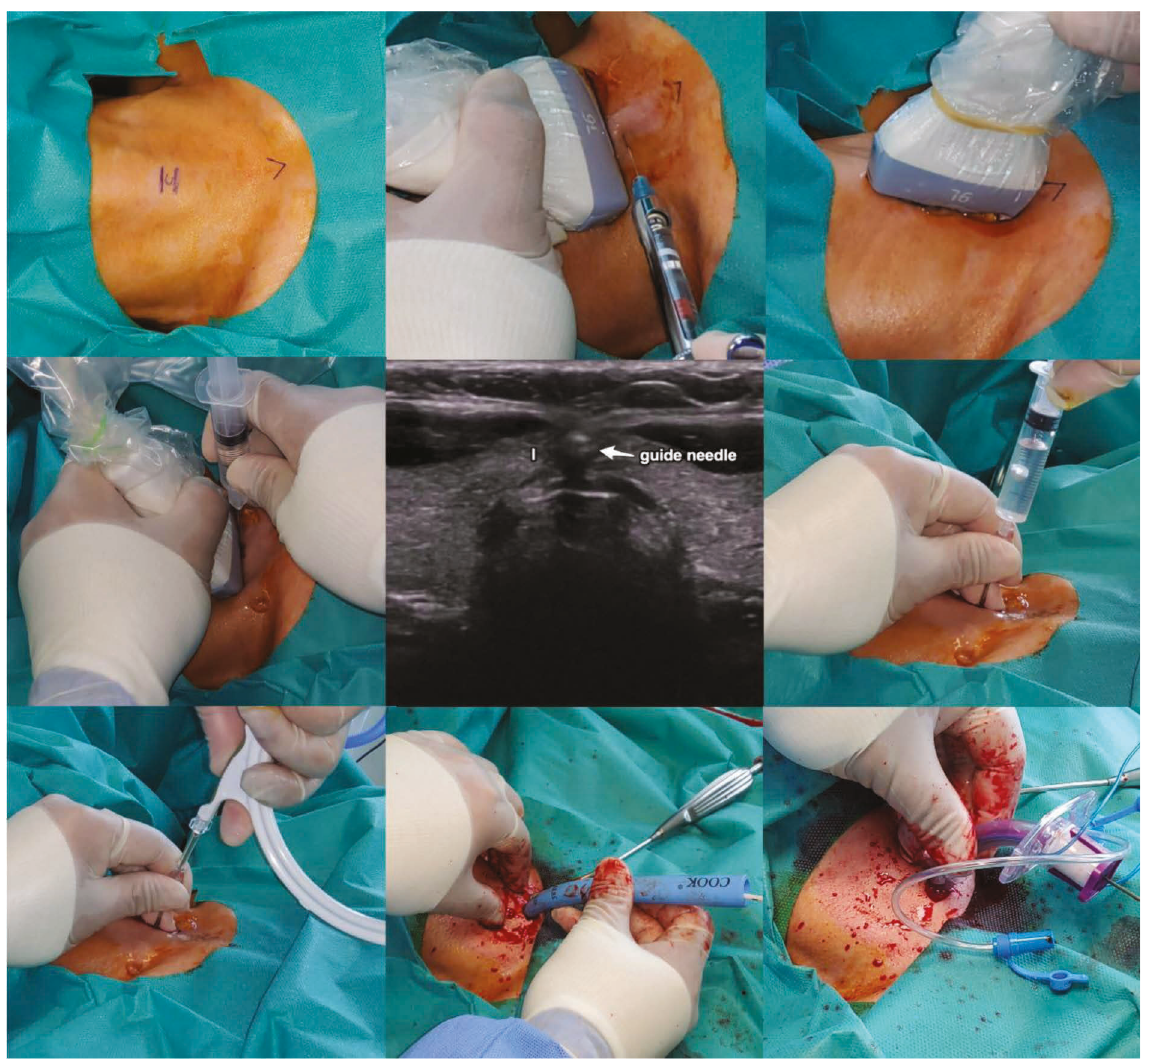
Figure 2: Real time ultrasound-guided percutaneous dilatational tracheostomy. After marking the cricoid cartilage and sternal notch, local anesthesia was injected superficial to the thyroid isthmus. Under sagittal conversion of the ultrasound probe, the ETtube was repositioned to an appropriate level to prevent tube puncture. The guide needle was inserted carefully to avoid damaging the cervical vasculature in the axial ultrasound view, followed by air regurgitation and insertion of the guidewire. The T-tube could be inserted along the guidewire following stepwise multiple dilatations using the Ciaglia Blue Rhino tracheostomy kit. I: thyroid isthmus, ET tube: endotracheal tube, T-tube: tracheostomy